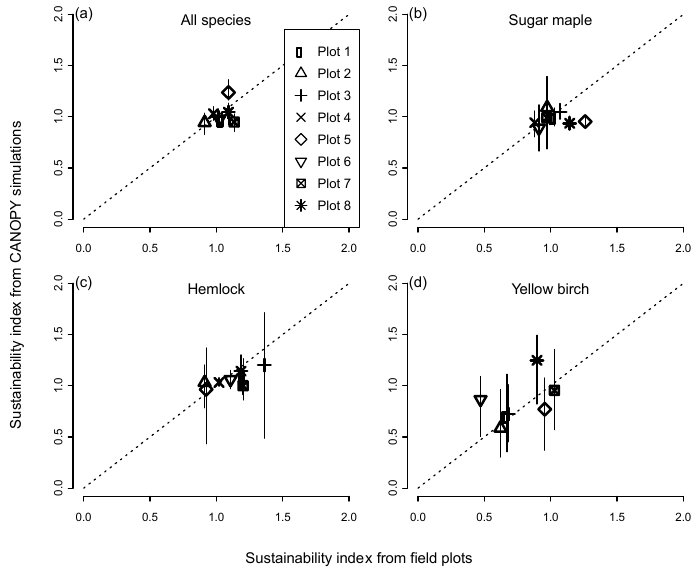
Figure 1. Demographic sustainability index for ( a ) all species pooled and ( b – d ) major individual species computed from 30-year permanent plot records compared to CANOPY simulations. Vertical lines denote the range of variation over 20 simulation replicates. Dotted lines indicate the line of perfect agreement between predicted and observed values.